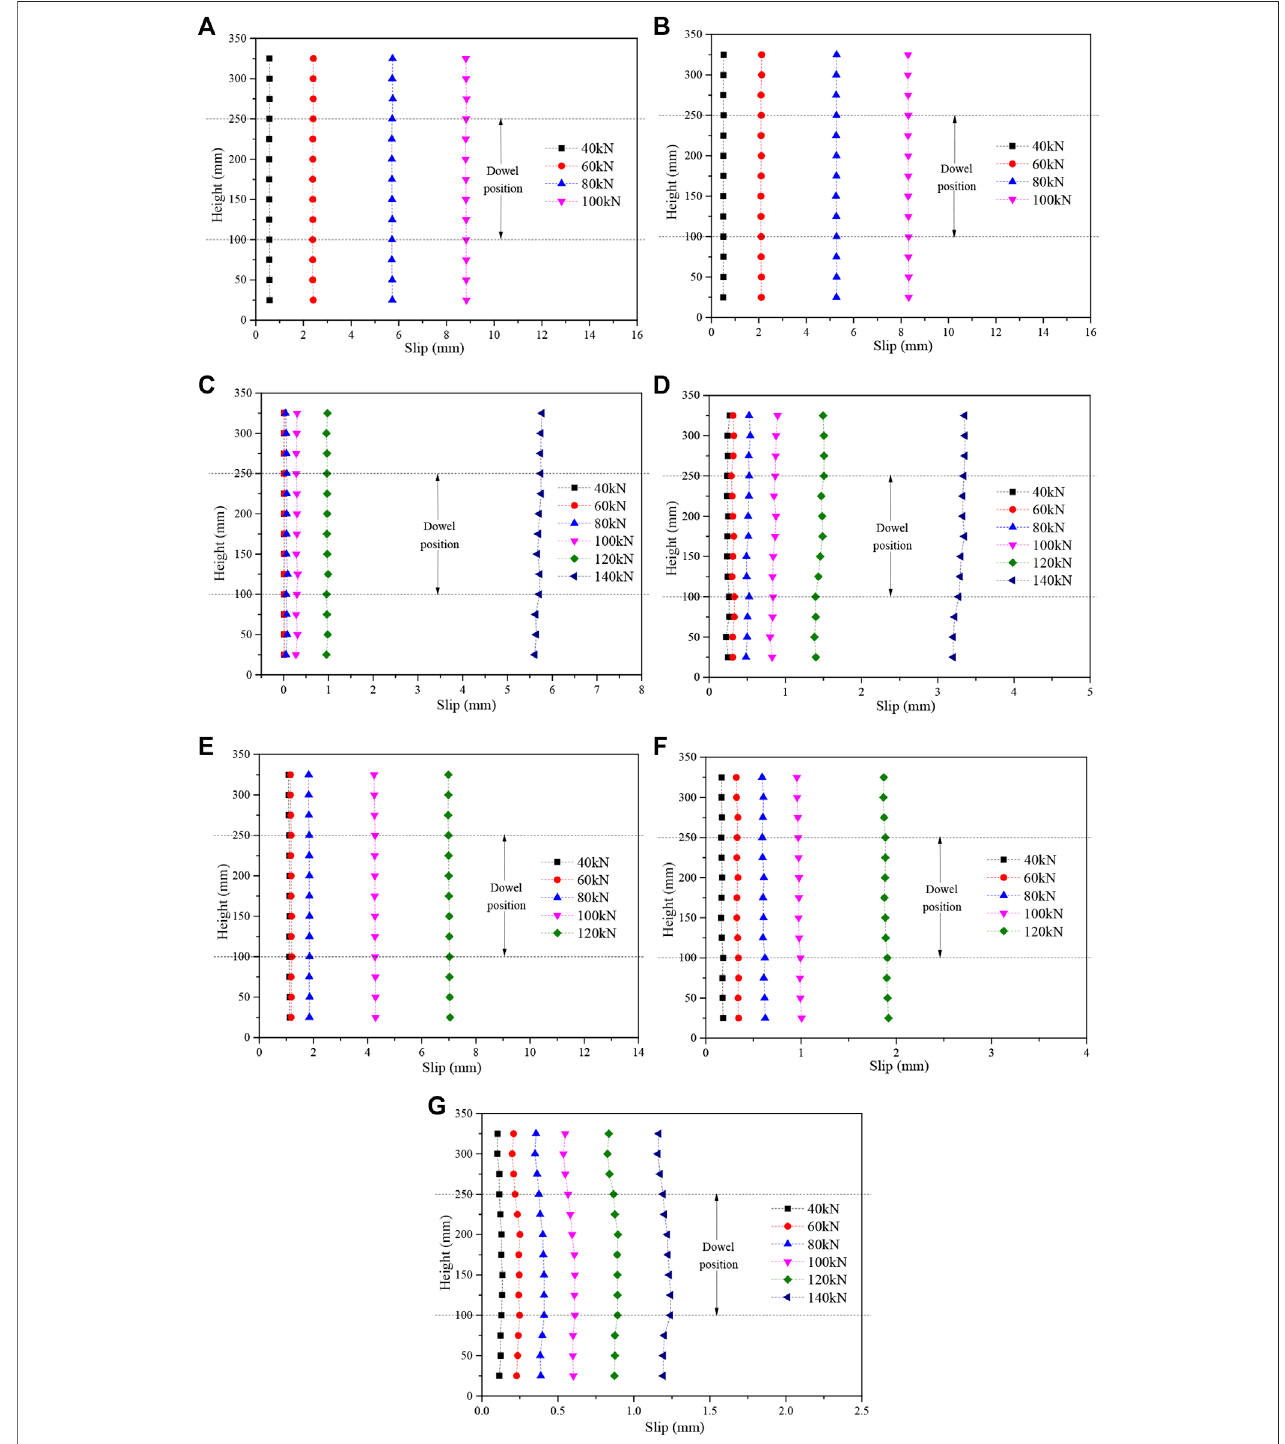
FIGURE 14 | The curves of the slip of bamboo-concrete specimens along interface height. (A) B3008-2 left, (B) B3008-2 right, (C) B3012-3 right, (D) B3016-1 right, (E) B5008-1 right, (F) B5012-3 right, (G) B5016-2 right.